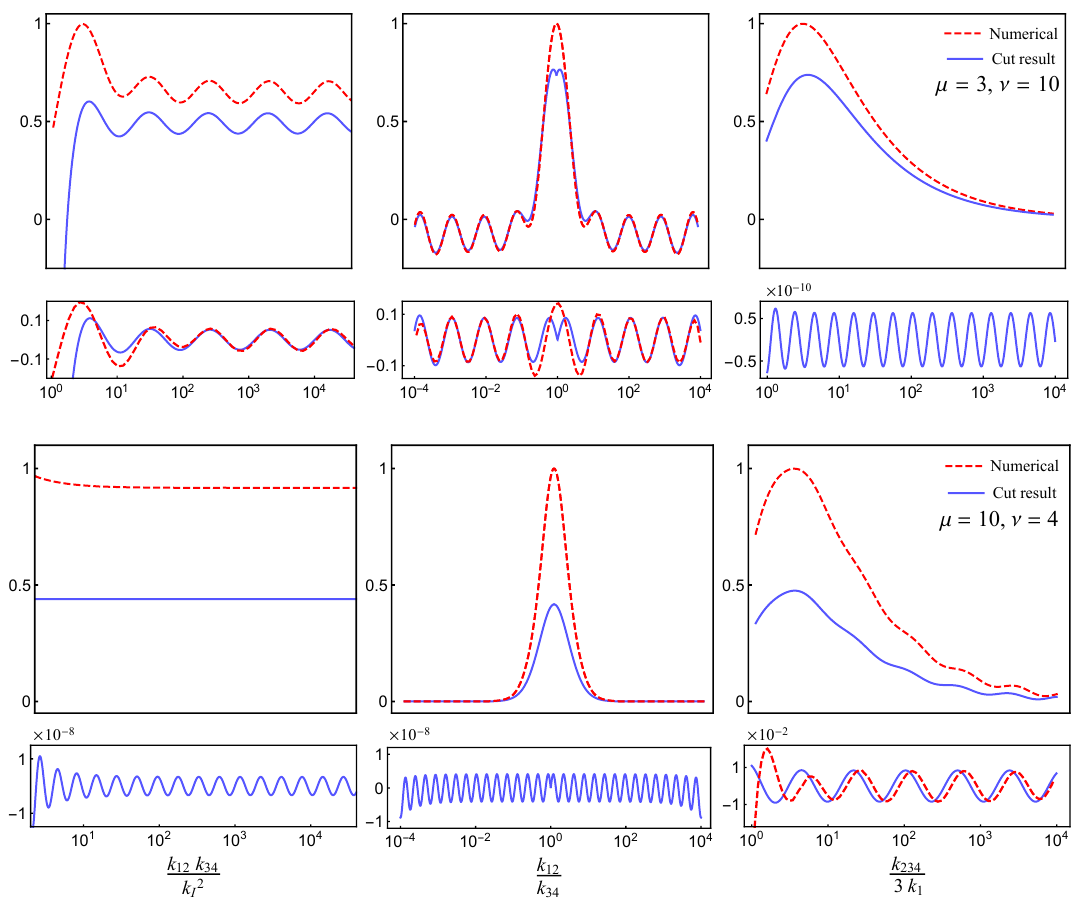
Figure 10 . The 4-point functions obtained from the cut rule (blue lines) and numerical integration (red dashed lines). Left column: non-local type CC signals in the (12 , 34) -channel, where we have (cid:0) (cid:1) 9 / 2 fixed k 12 /k 34 = 1 , and multiplied a factor k 12 k 34 /k 2 for better visualization. Middle column: I local type CC signals in the (12 , 34) -channel, where we have fixed k 12 k 34 /k 2 = 4 × 10 4 . Right column: I mixed type (non-local+local) CC signals in the (1 , 234) -channel, where we have fixed k 2 = k 3 = k 4 . The first row corresponds to the mass choice µ = 3 , ν = 10 , while the second row corresponds to the mass choice µ = 10 , ν = 4 . The 4-point functions are normalized by their maxima. In the lower panels, we compare the CC signals filtered from the numerical result and that directly obtained via the cut. In cases where the CC signal strength is too weak, we have plotted the analytical cut result only, because the numerical accuracy is inadequate for signal